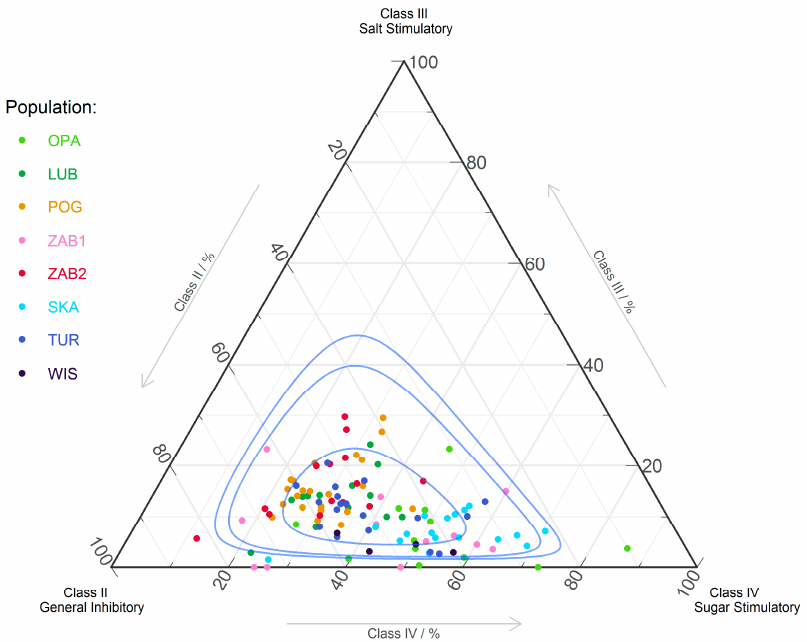
Figure 2. Ternary plot of amino acid classes for Neottia ovata populations: II (Asp, Glu, His, Arg, Lys), III (Hyp, Pro), and IV (Val, Met, Trp, Phe, Ile, Leu). Blue lines show 50%, 90%, and 95% confidence intervals via the Mahalanobis Distance and use of the Log-Ratio Transformation. The first class of AAs (Asn, Gln, Ala, Cys, Gly, Ser, Thr, Tyr) does not affect the chemoreceptors of fly (data not